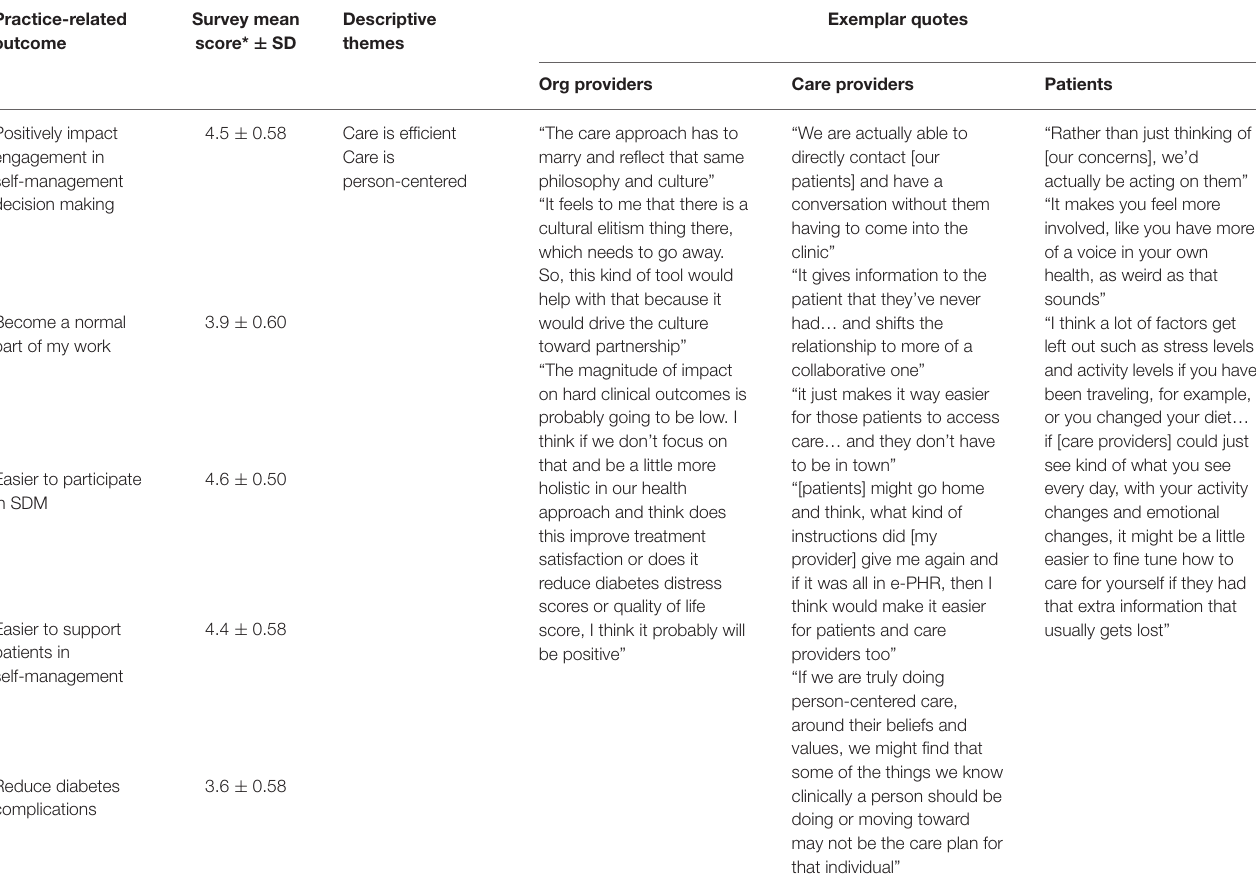
TABLE 10 | Combined qualitative and quantitative results for practice-related outcomes by study group. Practice-related